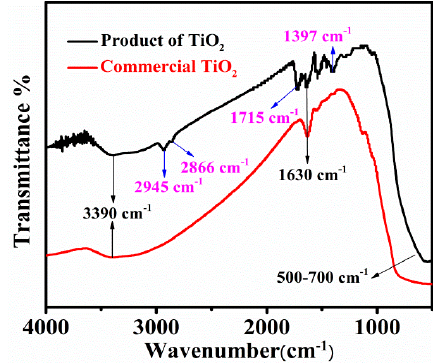
Figure 6. FT-IR spectra of product TiO 2 and commercial TiO 2.